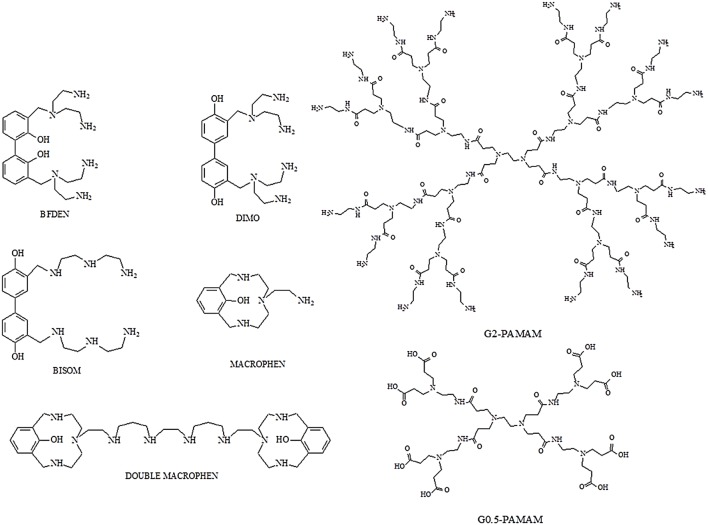
Structures of polyamino-phenolic ligands and dendrimers. BFDEN (3,3′-bis(N,N-bis(2-aminoethyl)aminomethyl)-2,2′-dihydroxybiphenyl), DIMO (3,3′-bis(N,N-bis(2-aminoethyl)aminomethyl)-4,4′-dihydroxybiphenyl), BISOM (3,3′-bis(N-(N-(2-aminoethyl)-2-aminoethyl)aminomethyl)-4,4′-dihydroxybiphenyl), MACROPHEN (2-(3,6,9-triaza-15-hydroxybicyclo(9.3.1)pentadeca-11,13,115-trien-6-yl)ethylamine), DOUBLE MACROPHEN (1,16-bis(3,6,9-triaza-15-hydroxybicyclo(9.3.1)pentadeca-11,13,115-trien-6-yl)-3,7,10,14-tetraazahexadecane), G0.5 PAMAM and G2 PAMAM.